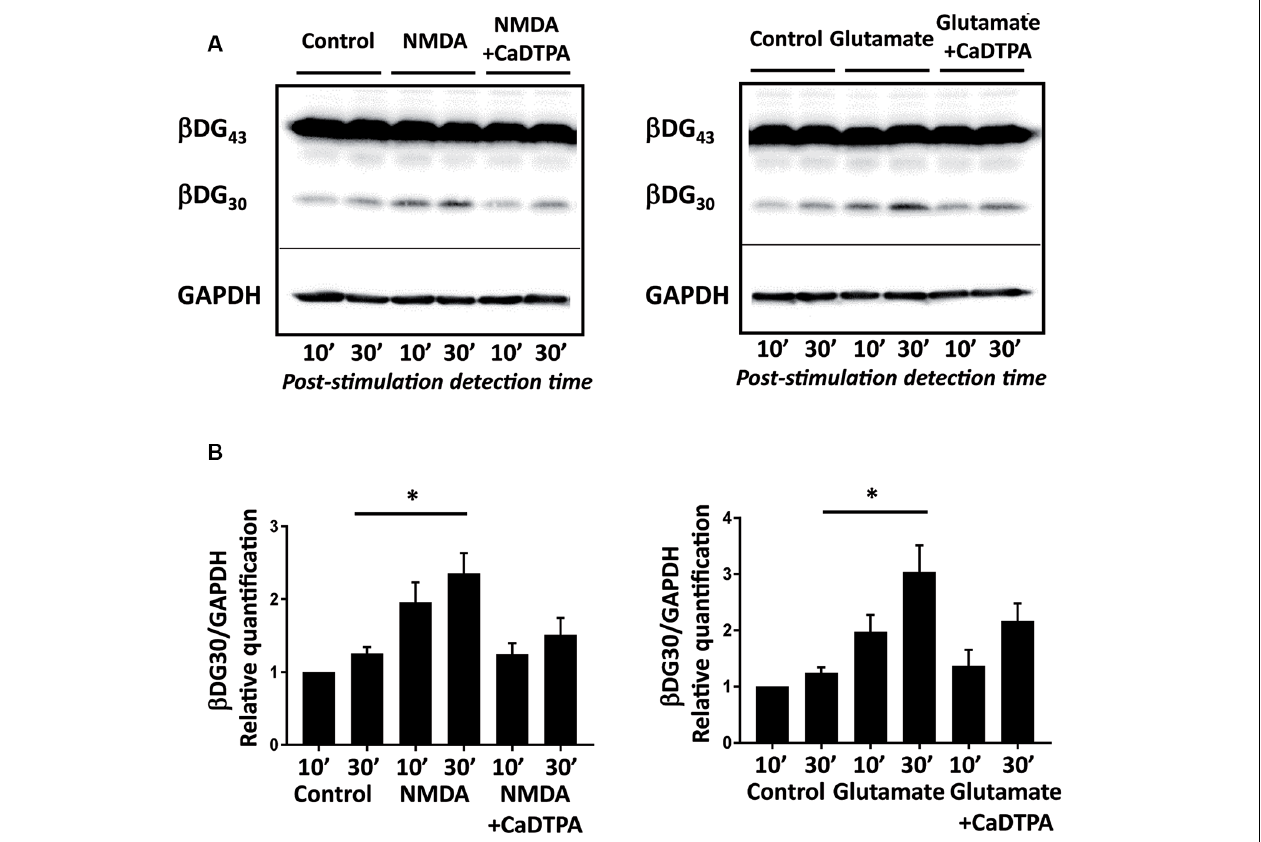
FIGURE 1 | NMDA or glutamate stimulations activate endogenous gelatinases in cultured neurons. ( A) Rat hippocampal neurons (14 DIV) were stimulated for 10 min with NMDA 100 µ M or glutamate 50 µ M with or without Ca-DTPA, a metal chelator and a broad range inhibitor of MMPs activity, then incubated for 10 or 30 min before lysis. Endogenous gelatinase activation was detected by cleavage of β -dystroglycan ( β -DG), an MMP-9 substrate, by Western Blot. (B) Quantification of 30 kD β -DG cleavage product relative to GAPDH as a protein loading control. Graph represents mean values ± SEM ( n = 4 independent experiments). Non-parametric Kruskal–Wallis test ( p -value = 0.0018 for NMDA experiments and p -value = 0.0003 for glutamate experiments) followed by Dunn’s multiple comparison test where ∗ p < 0.05 (control 30 min vs. stimulation 30